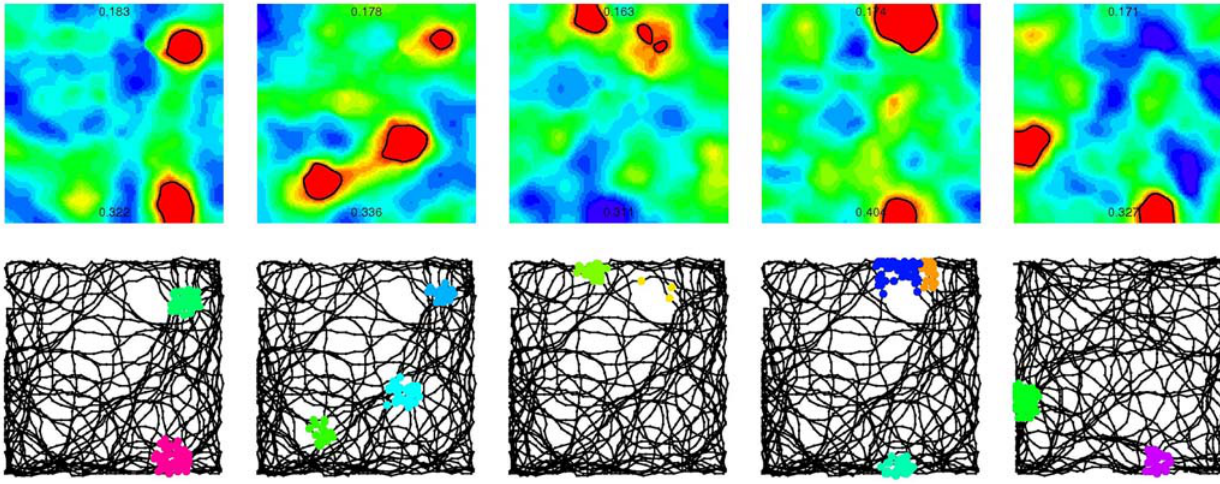
Figure 6. Location dependent input and parallel dendritic computations generate multiple place fields. The behavior of the same granule cell in five different environments (columns). Upper row: color-coded maps (‘‘ratemaps’’) show the somatic activation on the 1 6 1 meter large maze. Red: high activation (spiking), blue: silent. The highest and the lowest value of the somatic activation is indicated on each ratemap. The places where the activation exceed the threshold (‘‘place fields’’) are surrounded by black lines. We used the same, linear color-code in all panels. Lower row: the track of the robot and the location of the dendritic spikes. Dendritic place fields of different branches of the same neuron are marked by different colors. Somatic firing usually coincide with the activation of single dendritic branches.